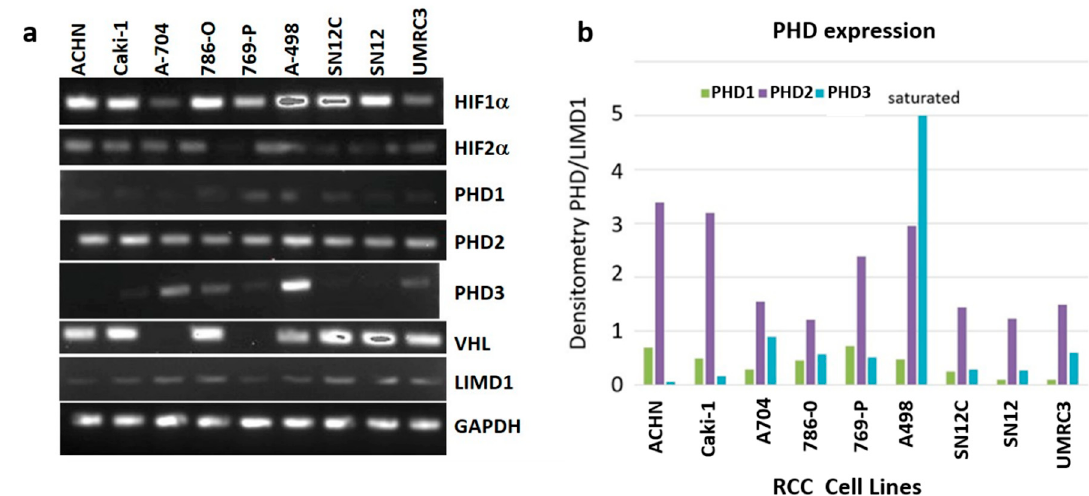
Figure 1. RCC cell lines show varying levels of PHD3 expression. ( a ) Agarose gel electrophoresis of RT-PCR products of RNA isolated from the indicated RCC cell lines shows varying levels of the PHD3 transcript. ( b ) Densitometry analysis of the gel shown in Figure 1a. Measurements are plotted as ratios of PHD1, PHD2, and PHD3 to the scaffold protein LIMD1. Transcript signal in the A-498 lysate was found to be saturated.